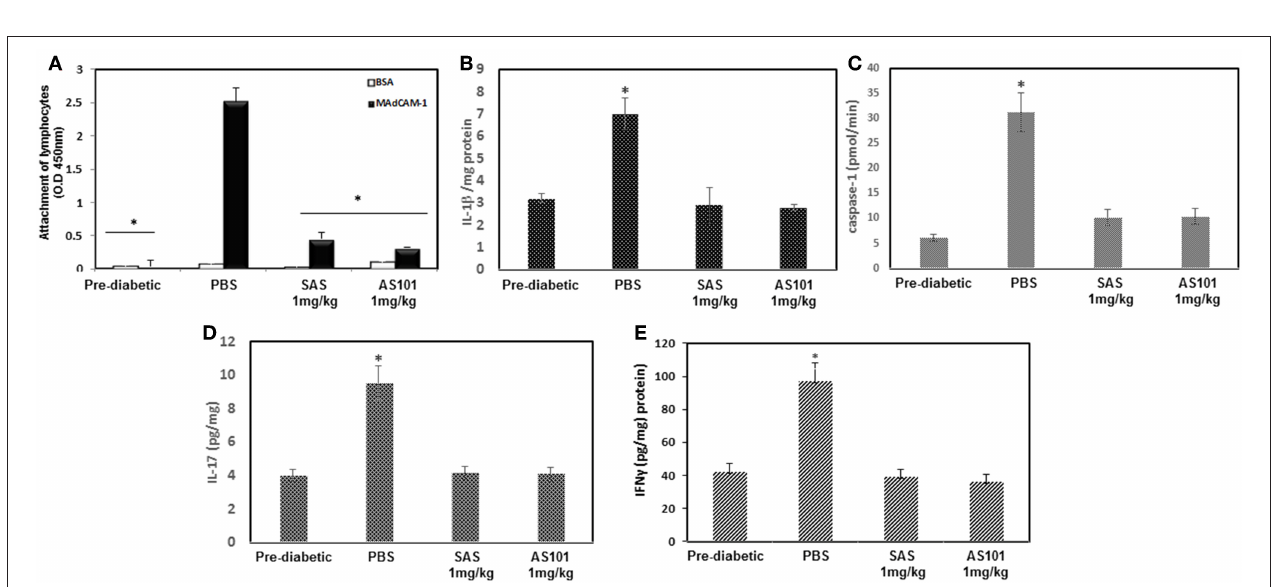
FIGURE 10 | Treatment with AS101 or SAS attenuates α 4 β 7 integrin activity and suppresses inflammatory cytokines in NOD mice. (A) AS101 or SAS at 1 mg/kg/injection were administered i.p. every other day to female NOD mice, starting at 3 weeks of age until 20 weeks. Pre-diabetic mice at 5 weeks of age served as controls. Lymphocytes from PAN LN at 5 × 10 5 /well were isolated and incubated in 96 well plates coated with BSA or MAdCAM-1 for 2h. Nonattached cells were then washed twice, and the adherent cells were subjected to XTT. The results represent means ± SE of 8 mice/group. * p < 0.01 vs. MadCAM-1 alone. (B) IL-1 β protein levels from 20w old mice. Pancreatic cell lysates were evaluated for IL-1 β by ELISA. The results represent means ± SE of 5 mice/group. * p < 0.01 vs. PBS. (C) At 20 weeks pancreas cell lysates were analyzed for caspase-1 activity by a colorimetric assay, IL-17 (D) and IFN γ (E) protein levels by ELISA.. The results represent means ± SE of 3 mice/group. * p < 0.001 vs.